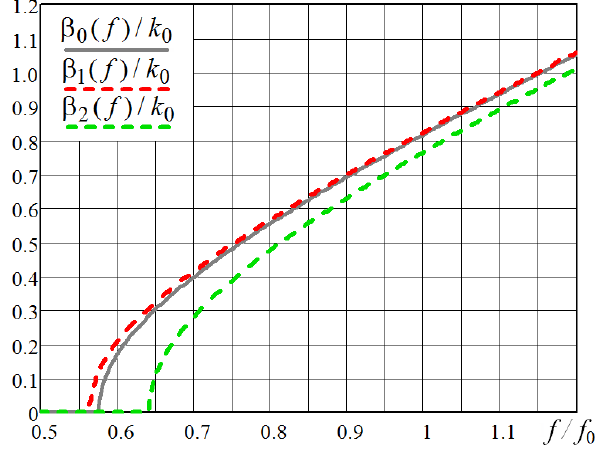
FIGURE 3. Dispersion diagrams for TE eigenmodes of a square waveguide with and without diagonally located square corner conducting irises